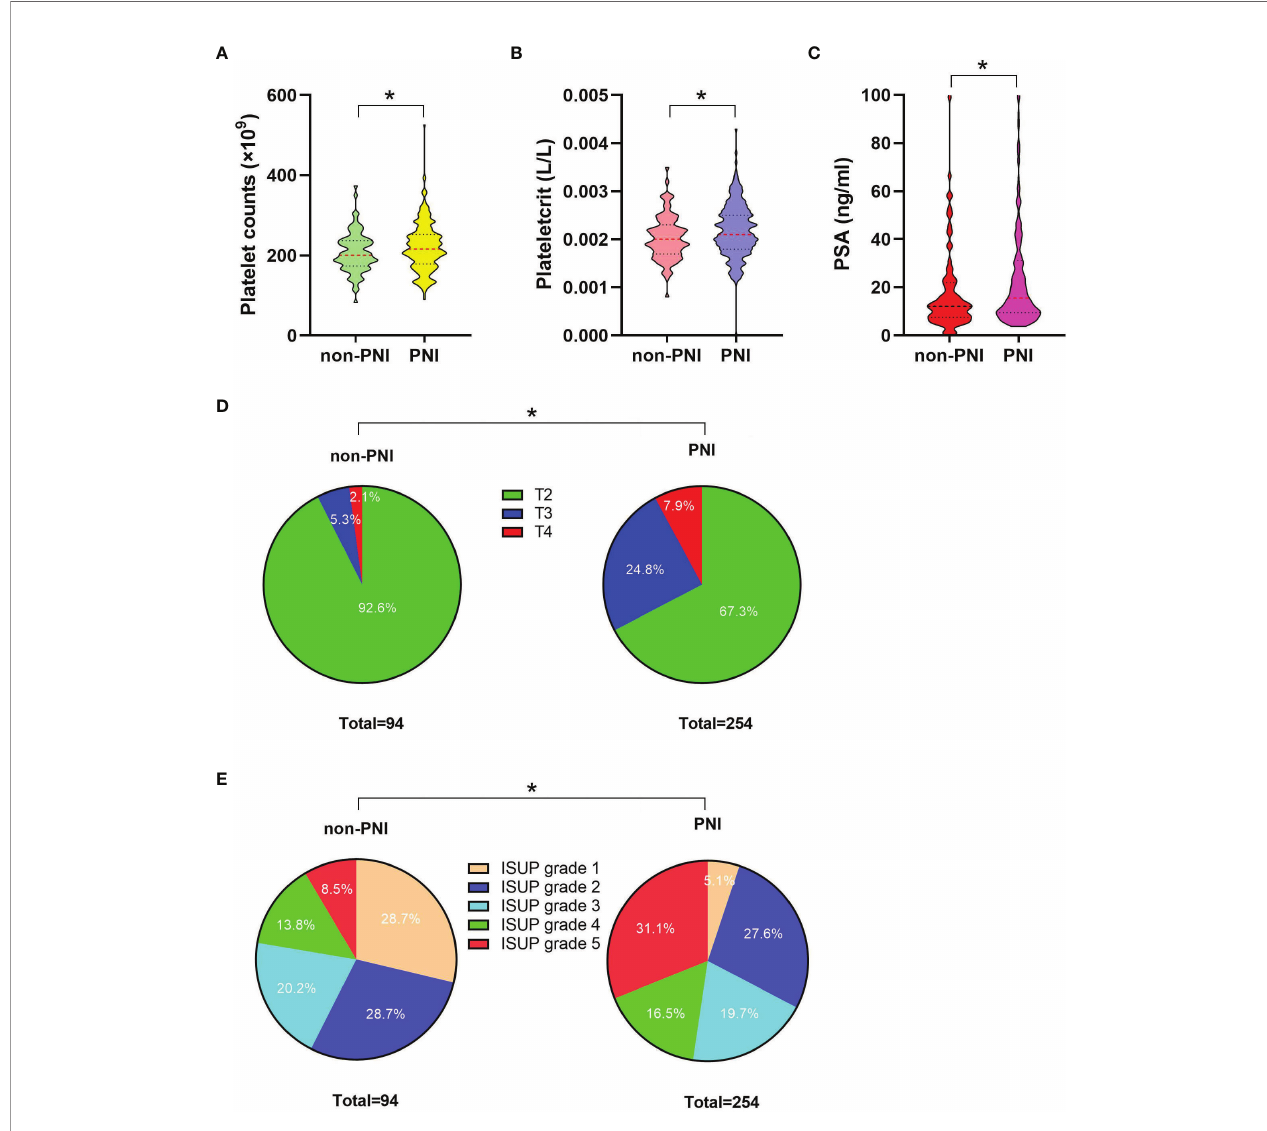
FIGURE 2 | The comparisons of platelet count, plateletcrit, PSA level, the percentage distributions of pT, and IUSP grade between the non-PNI (n = 94) and PNI (n = 254) groups. (A) Comparison of platelet count between the non-PNI and PNI groups; median (interquartile range) was measured and showed in a violin plot (the dotted line); statistical signi fi cance was determined by the Mann – Whitney U-test. (B) Comparison of plateletcrit between the non-PNI and PNI groups, median (interquartile range) was measured and showed in a violin plot (the dotted line), statistical signi fi cance was determined by the Mann – Whitney U-test. (C) Comparison of PSA levels between the non-PNI and PNI groups; median (interquartile range) was measured and showed in a violin plot (the dotted line); statistical signi fi cance was determined by the Mann – Whitney U-test. (D) Comparison of pT distribution (including T2, T3, and T4 percentages) between the non-PNI and PNI groups; a pie plot was generated to visualize the proportional change of the numerical data; statistical signi fi cance was determined by c 2-test; (E) Comparison of ISUP grade distribution (including proportions of ISUP grades 1, 2, 3, 4, and 5) between the non-PNI and PNI groups; a pie plot was generated to visualize the proportional change of the numerical data; statistical signi fi cance was determined by c 2-test. Values are expressed as median with interquartile range or number (percentage); *, P < 0.05. PSA, prostate-speci fi c antigen; pT, pathological stage T; ISUP, International Society of Urological Pathology; PNI, perineural